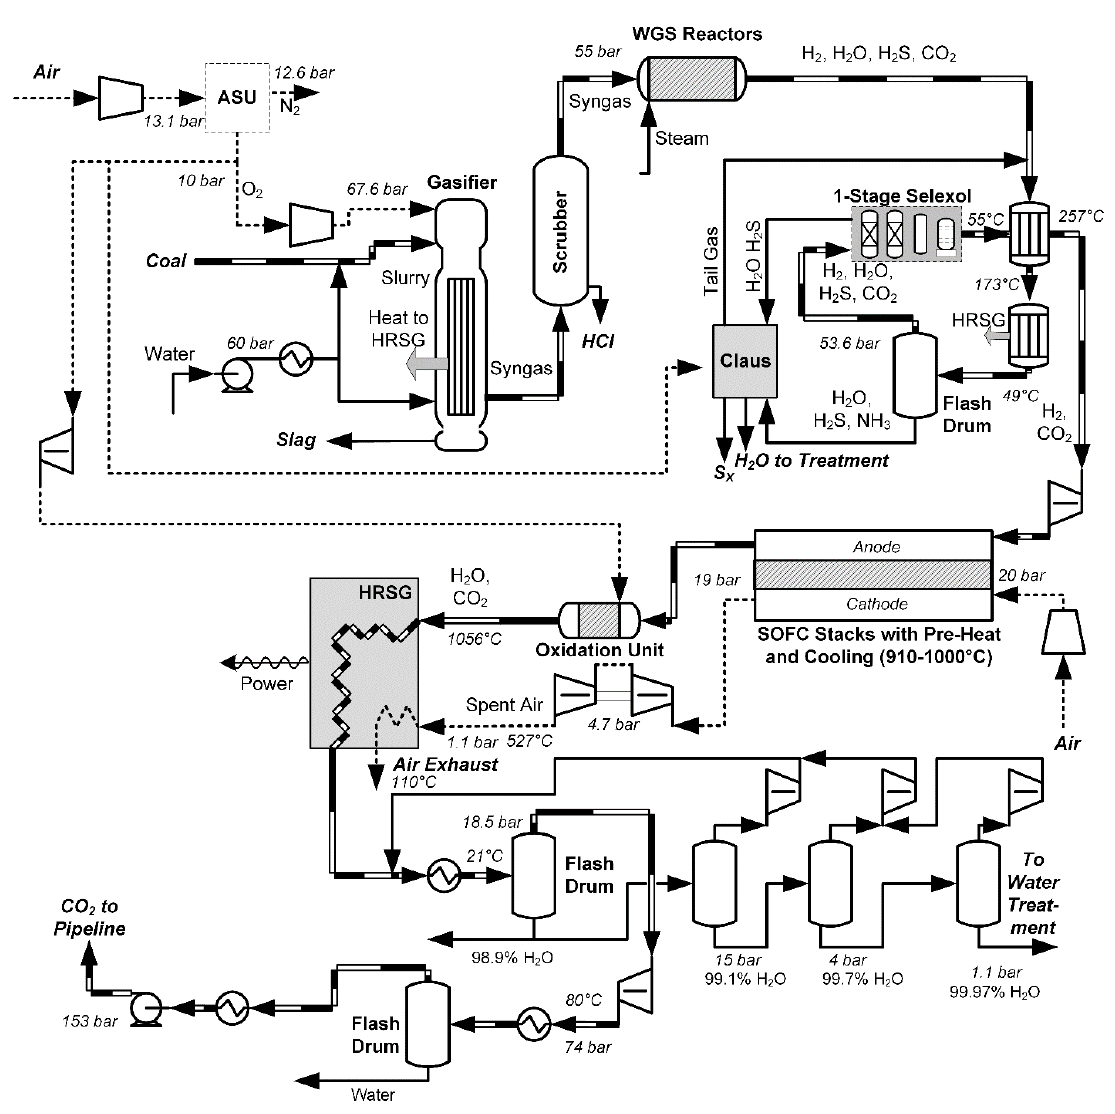
Figure 6. An example SOFC process from coal (also called integrated gasification fuel cell or IGFC), based on [25].